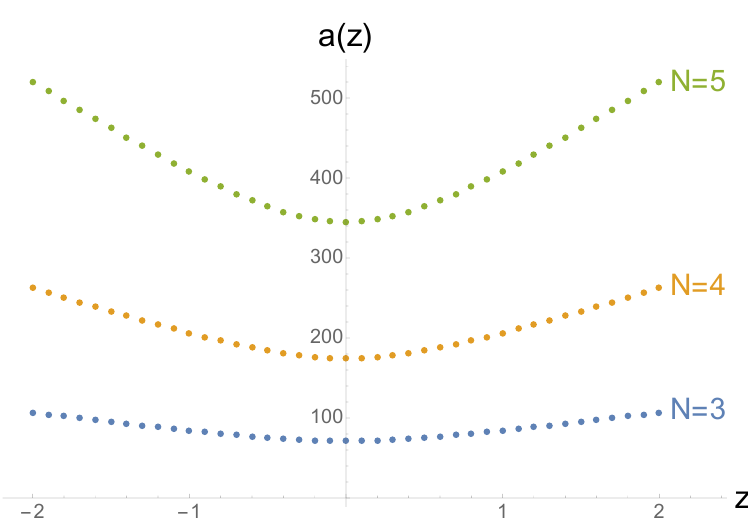
2 glued T ( m i ) blocks, N (cid:0)